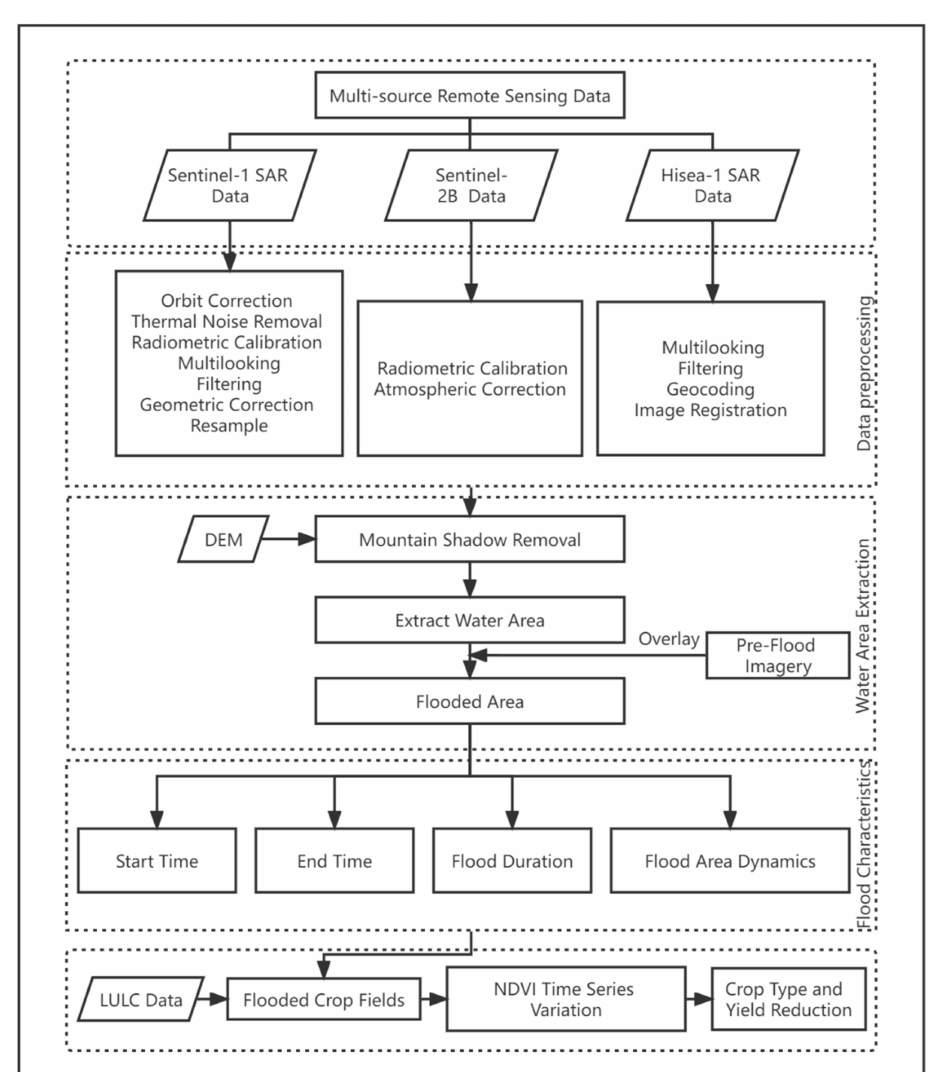
Figure 3. Flowchart of the flood feature extraction and crop loss analysis methods performed for the 20 July 2021 extraordinary rainfall event in Henan,